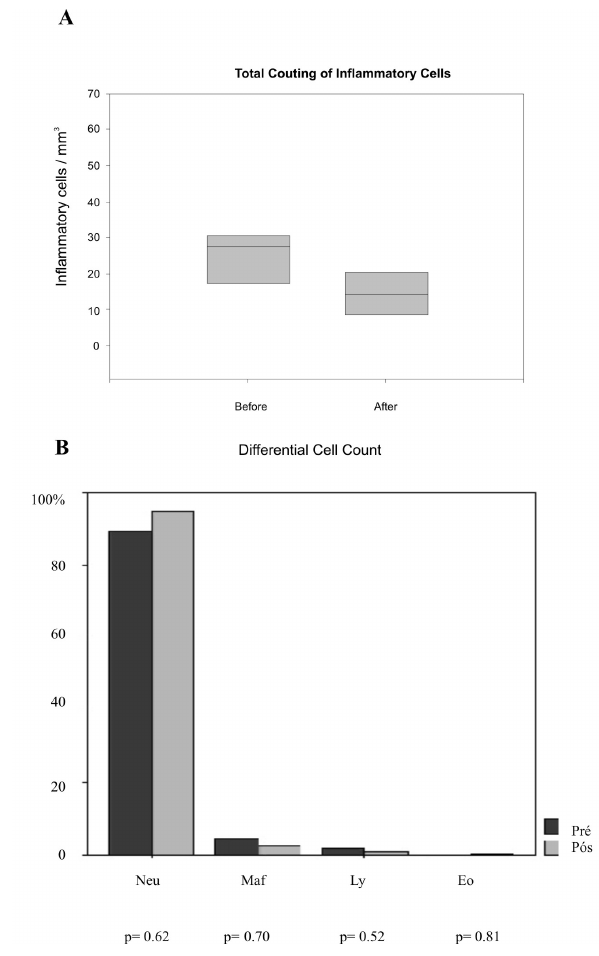
Figure 1 - The exhaled NO levels immediately before and 15 days after IVIG in seven secretive patients with CVID associated to bronchiectasis. Note the decrease in NO levels after the treatment (p<0.05)